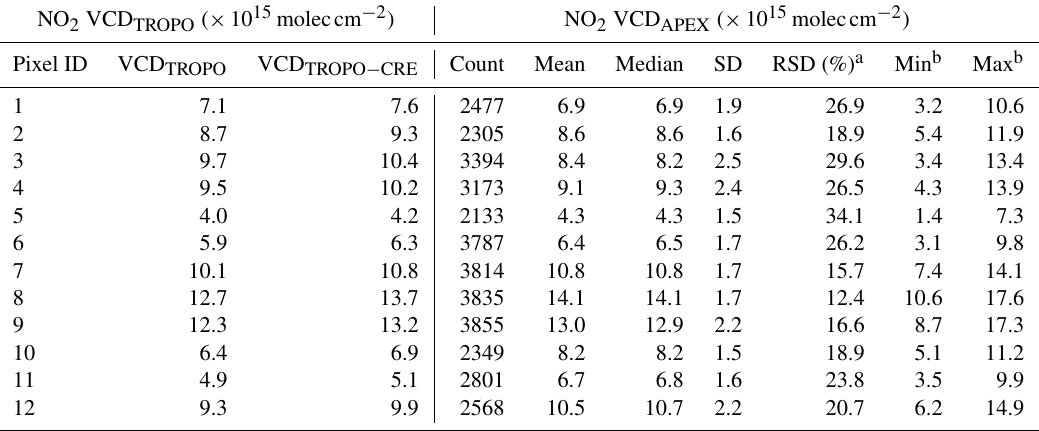
a Relative SD (RSD) or coefficient of variation defined as the ratio of the SD to the mean. b The minimum and maximum are defined here as µ − 2 σ and µ + 2 σ , in order to reduce the impact of outliers.